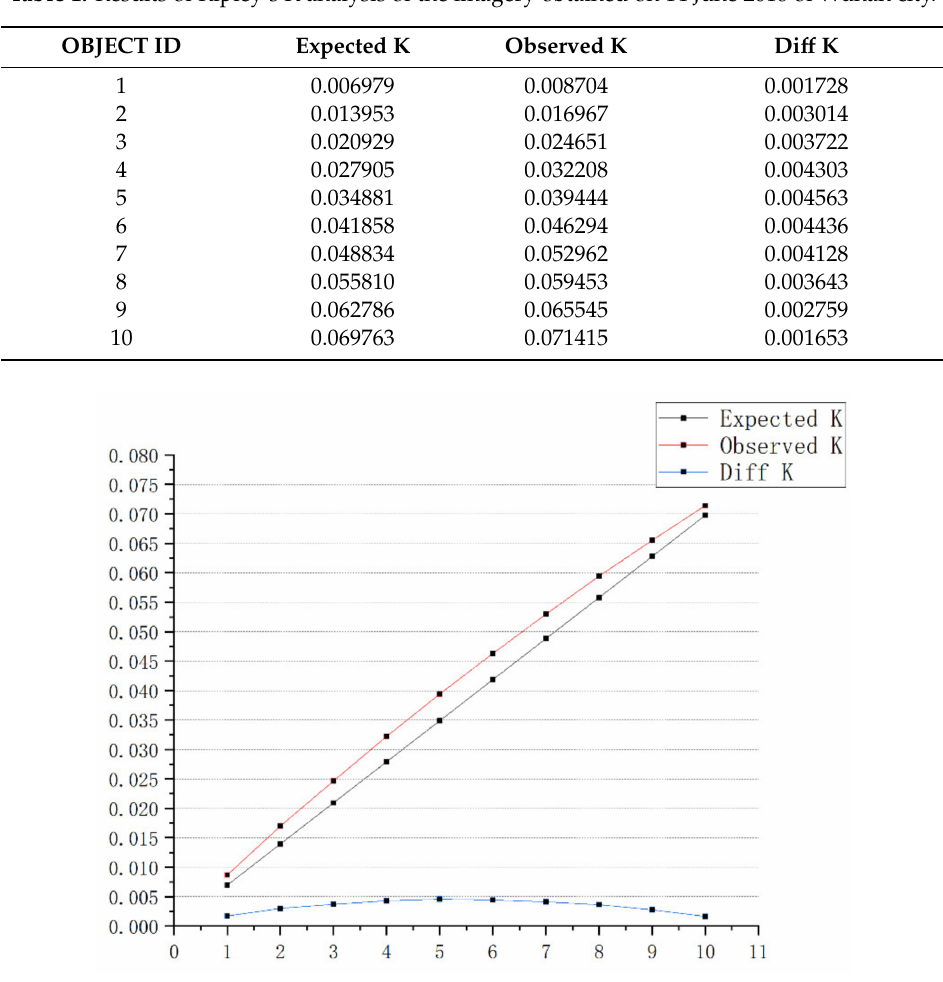
Figure 4. Ripley’s K multidistance mode analysis result with nighttime lights satellite